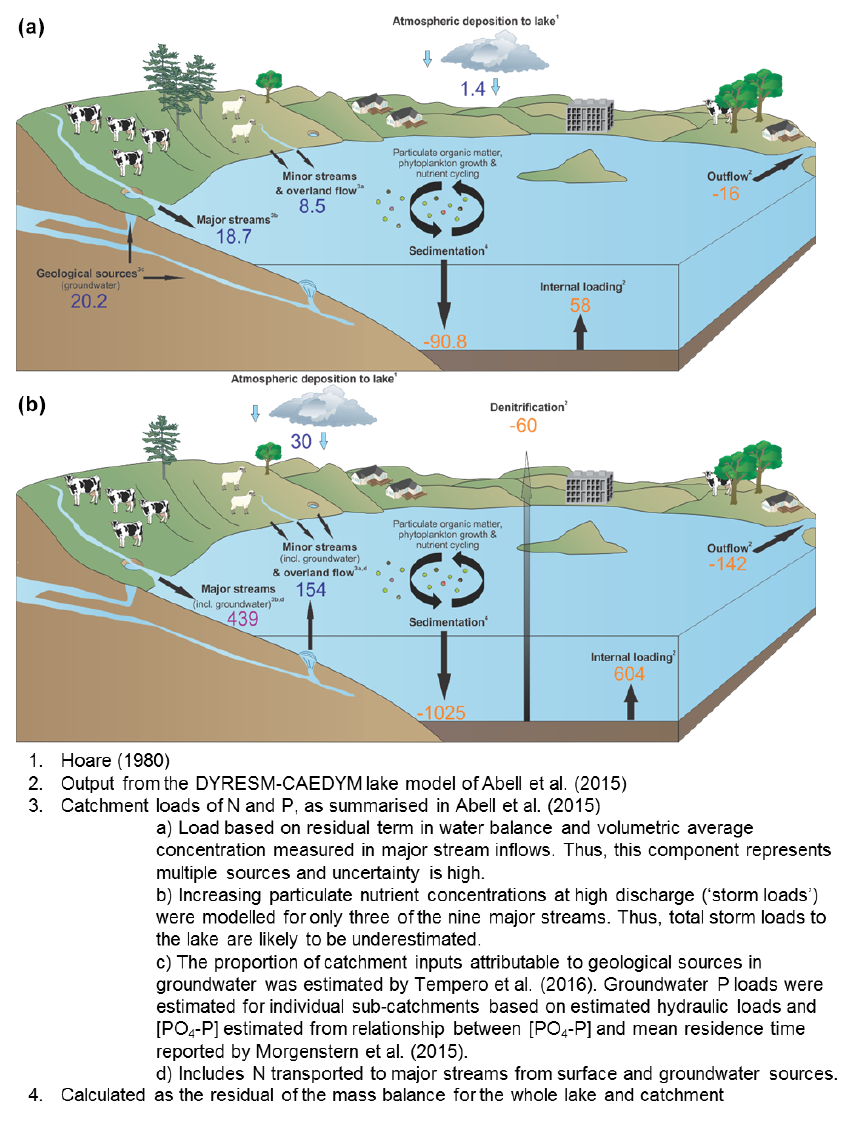
Figure 1. Catchment and lake nutrient budgets for Lake Rotorua for (a) phosphorus (P) and (b) nitrogen (N). Units are tonnes of total nutrient (P or N) per year. Values are annual averages for the period 2007–2014 when aluminium sulfate was applied to two lake inflows. Values in purple are based on annual means of observations, orange are derived from outputs from a 1-D lake model, and blue are estimated using other methods (see notes). Calculation methods differ from those used to measure progress towards lake action plan